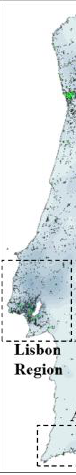
Figure 5. KDE for intensity VI overlaid with the location of the urban areas in black polygons (continuous urban fabric) and green (discontinuous urban fabric). Lisbon region and Algarve (in the dashed box) are the regions where higher seismic intensities